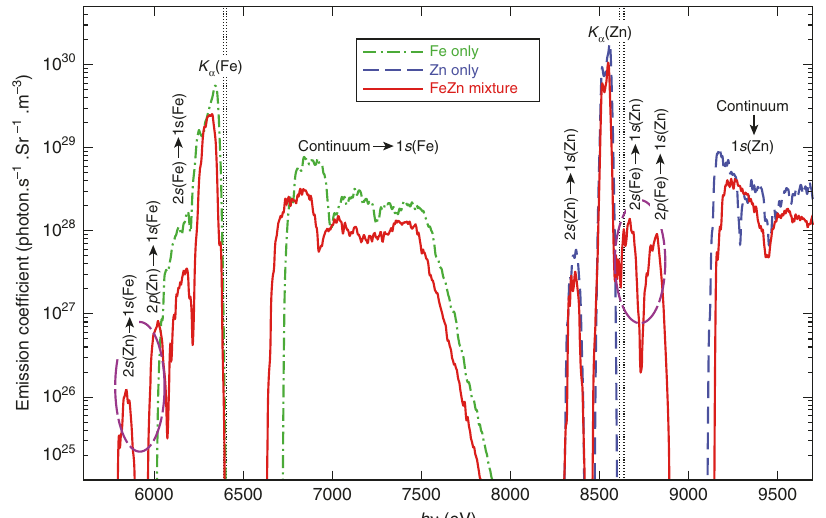
Fig. 2 The emission spectra of superdense plasmas. Three cases are calculated for Fe-only, Zn-only, and Fe – Zn mixture having 1 s vacancy at ρ = 1000 g cm − 3 and kT = 50 eV, using density-functional theory (DFT) with is shown by the solid-red line in Fig. 2. To identify the IRT features, we also plotted the spectra of single-species Fe (dashed – dotted green line) and Zn (dashed blue line) plasmas in